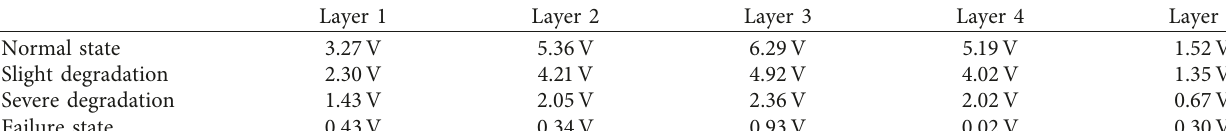
Table 1: RMS statistics of MMS components.